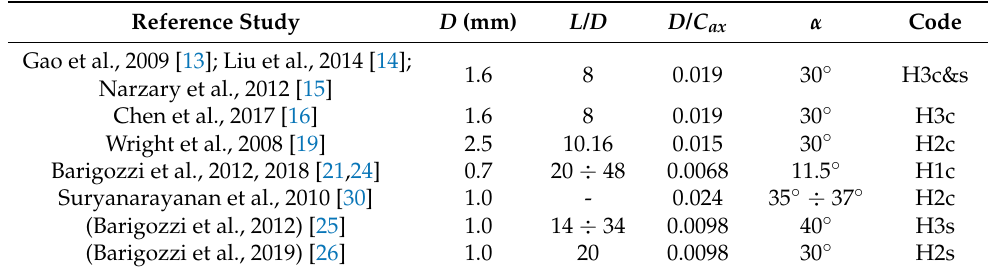
Table 2. Typical hole geometrical parameters.